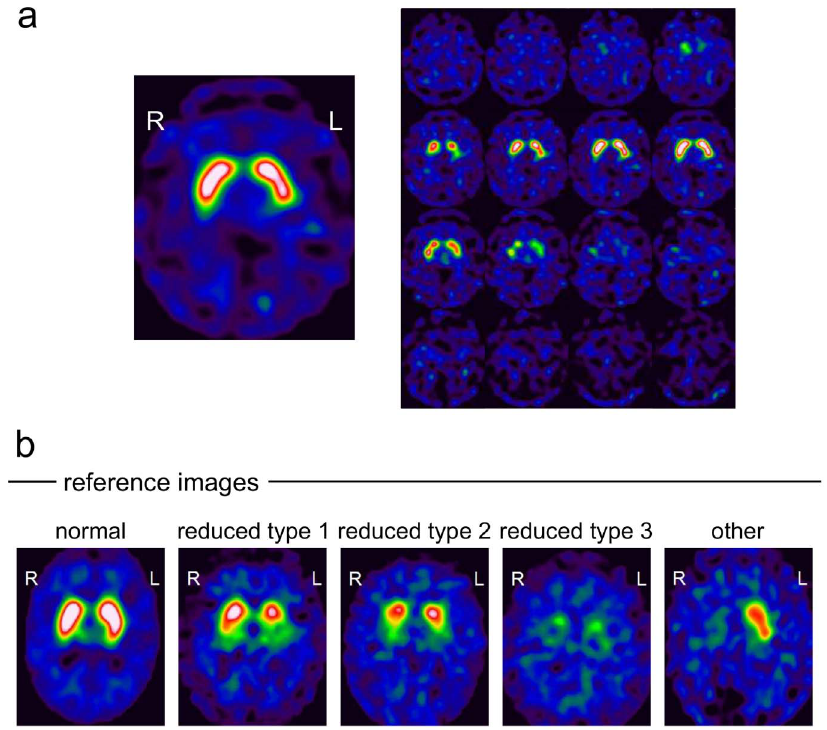
Figure 2. Example page from the pdf document for visual scoring. The pdf document comprised one page for each I-123-ioflupane SPECT image showing a 12 mm thick slab ( a, left ) and 4x4 slices of 4 mm thickness ( a, right ). Example I-123-ioflupane SPECTs used as reference images for the visual scoring ( b ).